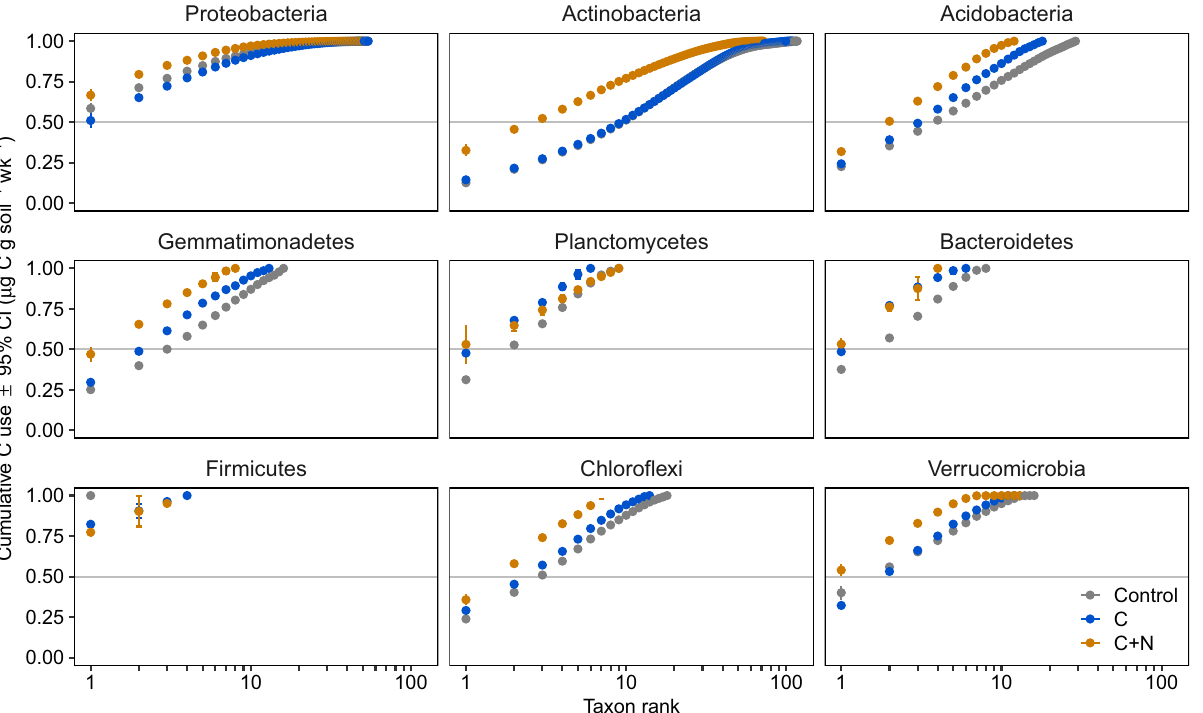
where P i indicates production of biomass carbon (µg C g dry soil − 1 week − 1 ) and C i indicates 16S copy number per cell for taxon i . The 0.2 coef fi cient represents an estimate that 20% of cellular mass is composed of carbon.